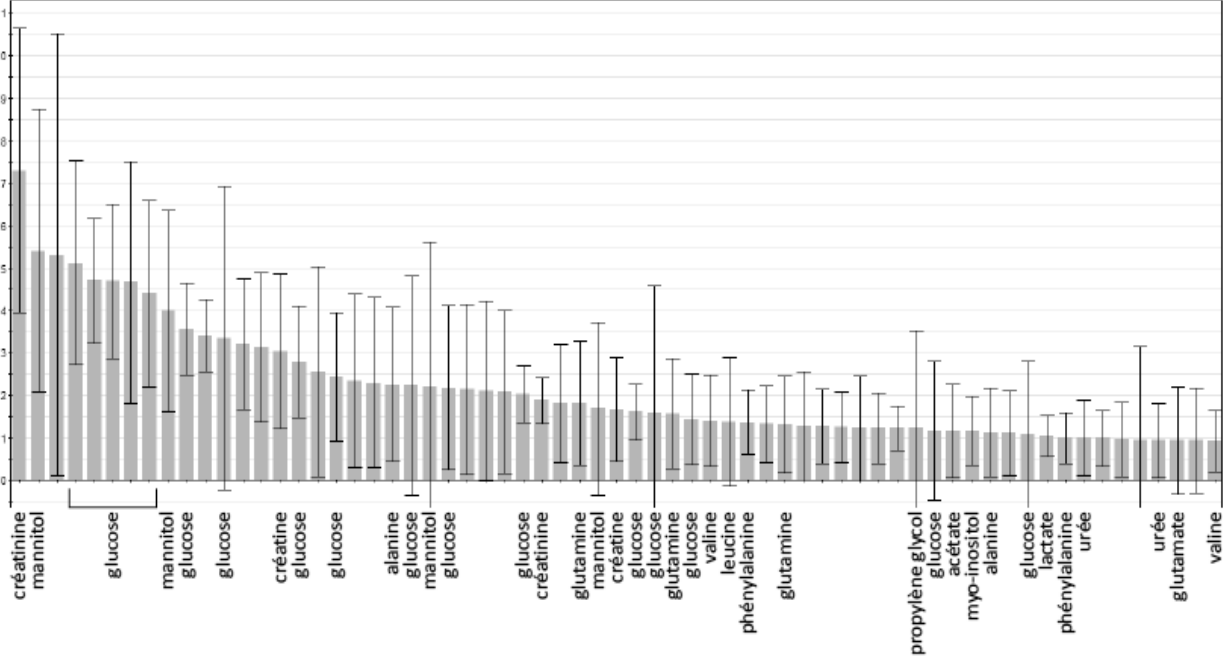
Figure 4. VIP plot (septic shock vs. ICU control group). Identified metabolites considered as relevant when VIP > 1: creatine, creatinine, urea, myo-inositol, phenylalanine, mannitol, alanine, valine, glutamine, glutamate, leucine.